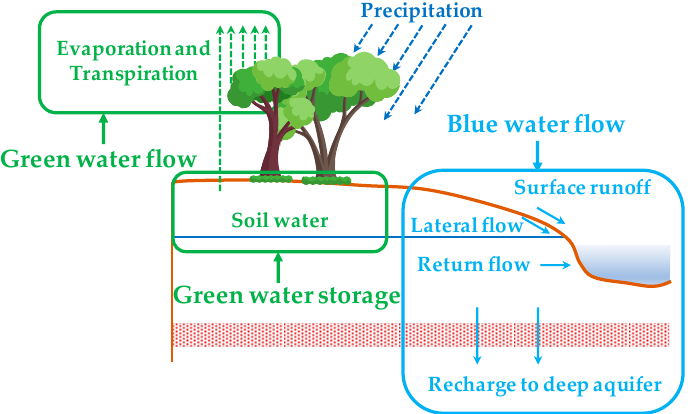
Figure 2. Schematic diagram of simulated components in the soil and water assessment tool (SWAT) model.